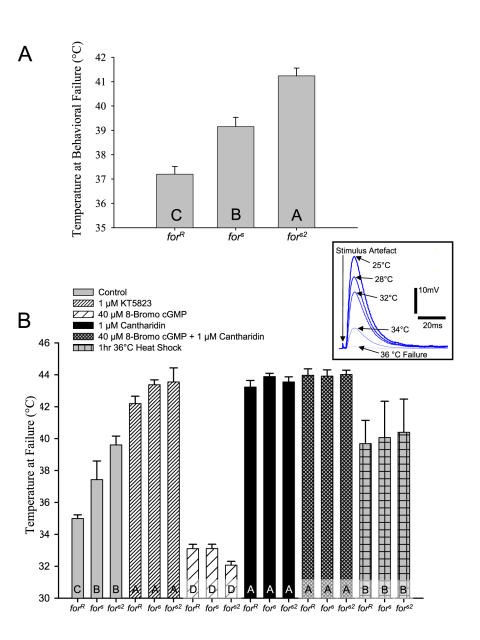
Hyperthermic failure of both behavior and NMJ synaptic transmission in 3rd instar forR, fors and fors2 Drosophila melanogaster larvae.(A) Temperature at behavioral failure of mouth hook movement significantly differed between larvae with different for genotypes, forR failed at 37.2°C±0.3 (N = 30), fors failed at 39.2°C±10.4 (N = 30) and fors2 failed at 41.2°C±0.3 (N = 30). Significant differences were found across groups (Kruskal-Wallis on ranks, H(2,90) = 37.617, p<0.001) where letters (A, B, C) denote significant differences using a post-hoc test (Tukey, p<0.05). (B) Hyperthermic failure of evoked excitatory junction potential (EJP) failure (see inset) at the NMJ N>5 for all genotype and treatment combinations. Decreased thermotolerance of evoked synaptic transmission correlated with genotype (fors2>fors>forR for thermotolerance), where significant differences were found across treatment groups (Two Way ANOVA, F(5,118) = 175.20, p<0.001). The involvement of PKG activity in thermotolerance was confirmed using pharmacological agents to activate PKG (40 µM 8-Bromo cGMP), inhibit PKG (1 µM KT5823) or inhibit a PKG phosphorylation target PP2A (1 µM Cantharidin). A combination of 8-Bromo cGMP and Cantharidin was also used, demonstrating that Cantharidin likely acts downstream of PKG activation. The three genotypes did not differ after being treated with a prior heat shock of 36°C for 1 hour and a 30 minute recovery. Letters in histogram bars represent statistical groupings using a post-hoc test, whereby bars with different letters are significantly different (Tukey, p<0.05). Error bars represent SEM.